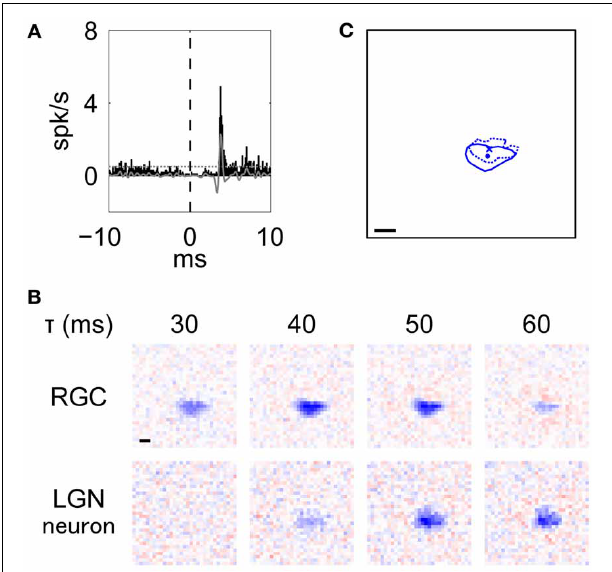
FIGURE 3 | Typical example of an RGC-LGN neuron pair with RFs of the same response sign. This was the pair shown in Figure 2S . (A) XC of the pair. Black bars and gray line indicate raw and filtered data, respectively. Horizontal dotted line indicates mean + 5 SD . (B) Spatiotemporal RF structures (top: RGC, bottom: LGN neuron; left to right: shorter to longer latencies). (C) Overlaid image of the RF centers. Solid line and dot indicate 50% of response level and center position of the RGC, respectively. Dotted line and cross-symbol indicate those of the LGN neuron. The RF center positions were obtained from the fitted parameters. In (B) and (C) , scale bar = 1 ◦ .